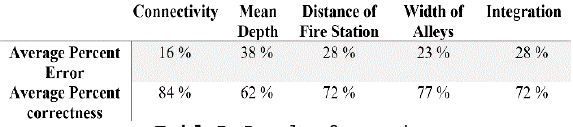
Table 5 . Results of